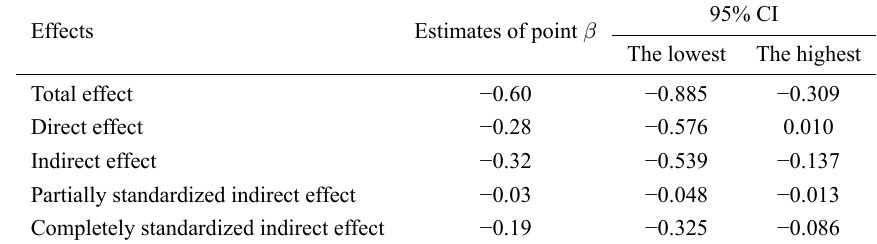
Table 4. Total, direct, and indirect effects of the sexual self-efficacy on the sexual dissatisfaction.